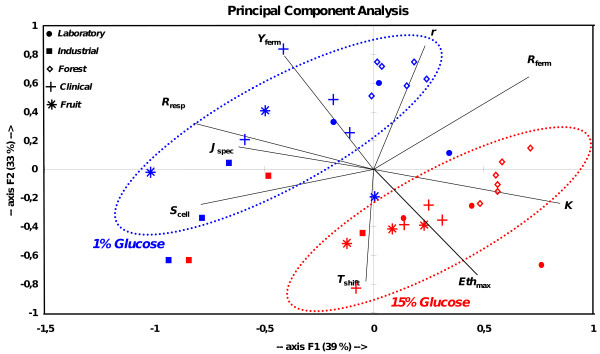
Principal Component Analysis realized on the six life-history traits (K, r, Scell, Rferm, Rresp, Tshift) and on the three metabolic traits (Yferm, Ethmax, Jspec). Filled circles correspond to laboratory strains, filled boxes to industrial ones, diamond to forest ones, crosses to clinical ones and stars to fruit ones. Red and blue symbols correspond to the two glucose conditions, respectively 15% and 1%.